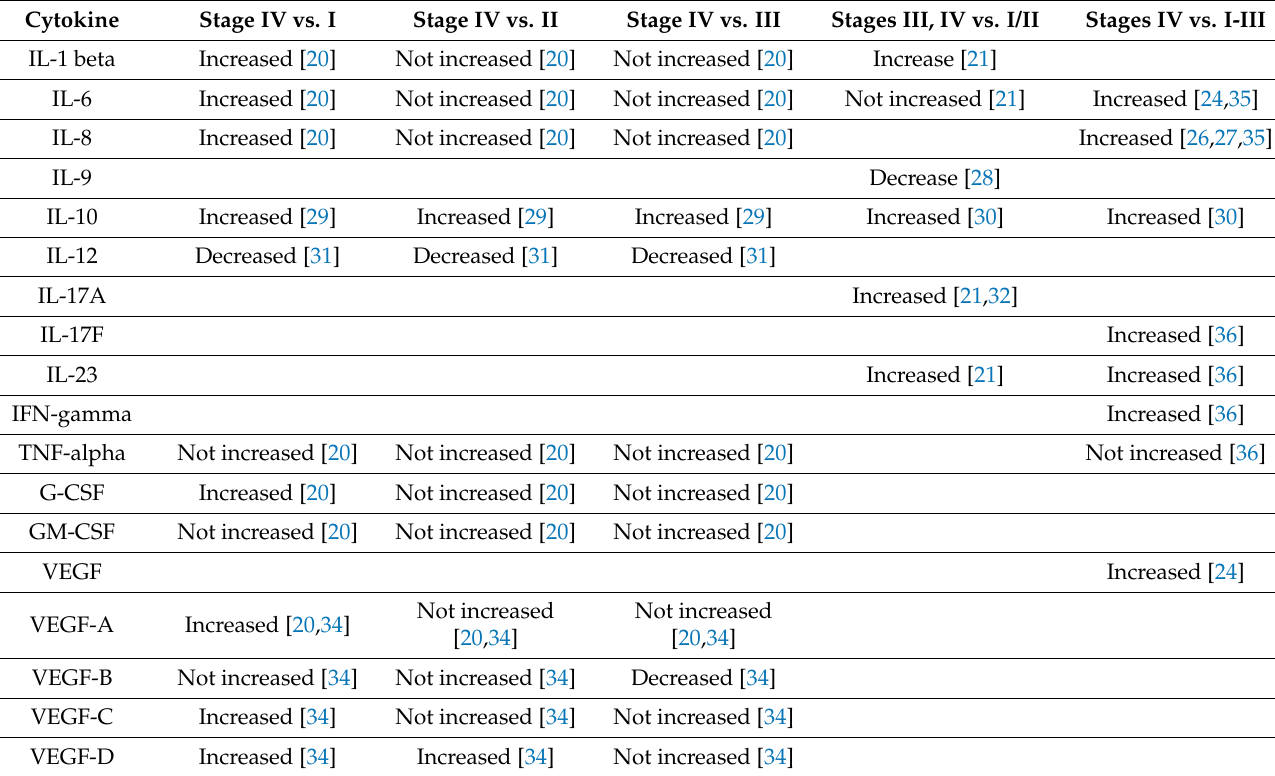
Table 2. Systemic cytokine levels in patients with different stages of